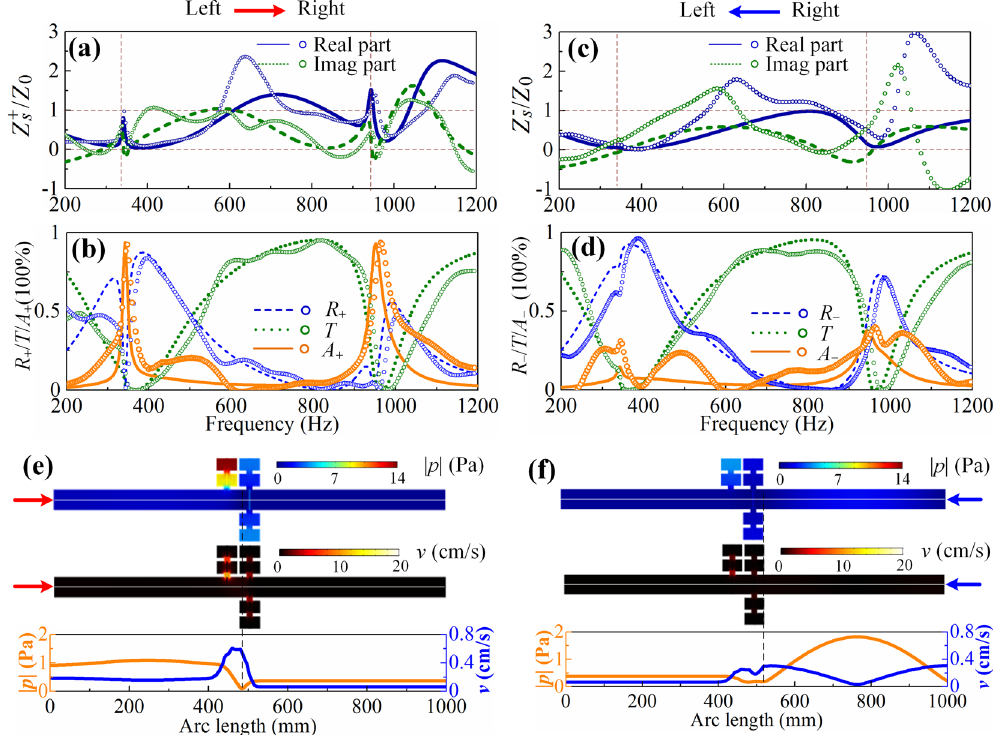
Figure 3. Normalized surface impedance of (a) the left side and (c) the right side of the asymmetric absorber where lines and symbols are for the theoretical and experimental results, respectively. (b – d) The corresponding reflectance (blue dashed lines/symbols), transmittance (olive dotted lines/symbols) and absorptance (orange solid lines/symbols). (e) and (f) are for the sound pressure and velocity when sound waves radiate from the left and right port,